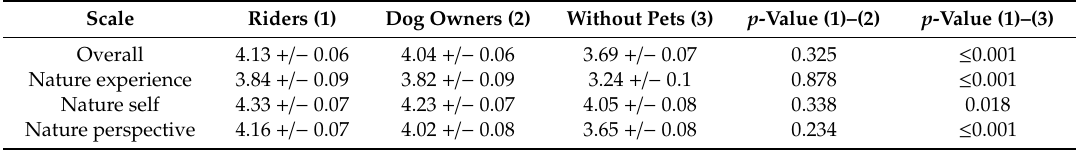
Table 1. Adjusted nature relatedness-score (mean +/ − SEM) and associated p -values of nature relatedness overall scale and